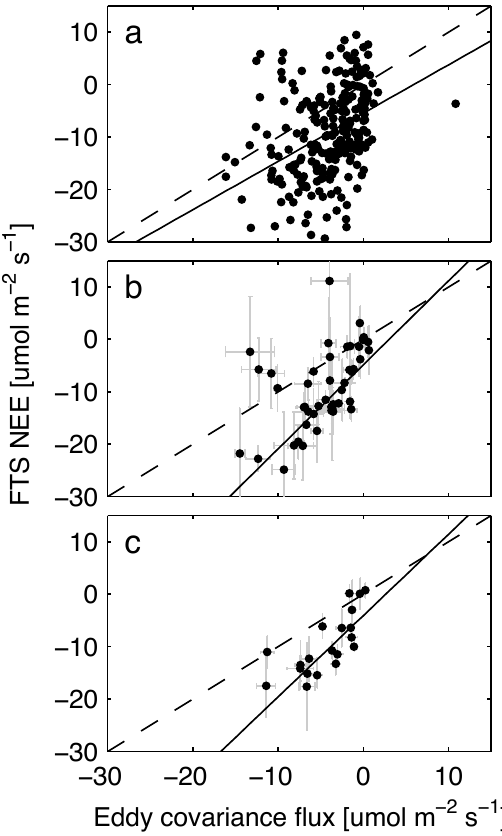
Fig. 5. Comparison between NEE calculated from drawdown in the total column and NEE infered from eddy covariance measurements at Park Falls, Wisconsin. Drawdown in the column is calculated over a 4h period symmetric about solar noon. Eddy covariance fluxes are averaged over the same time period. (a) NEE calculated each day for which data are available. (b) Data aggregated by week of year. (c) Data aggregated for each month. The dashed line rep- resents the 1:1 line, while the solid line represents the best fit to the